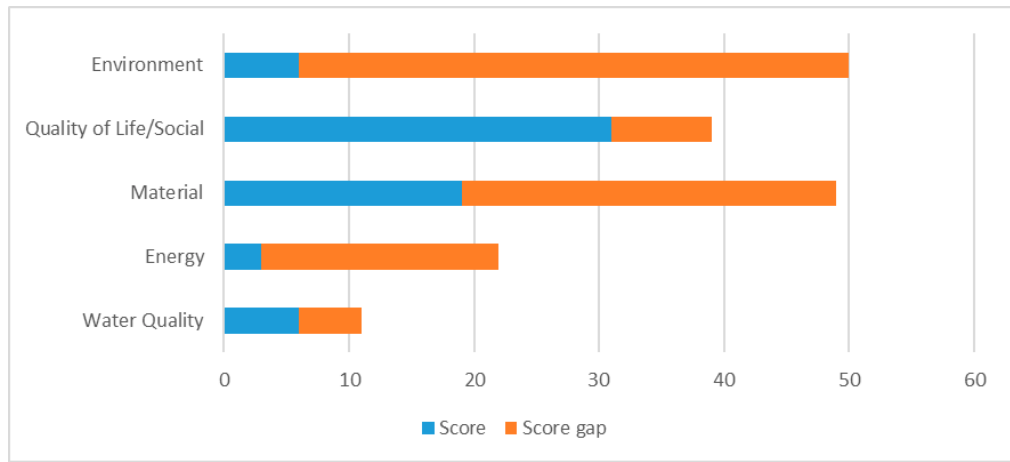
Figure 4. Points achieved in relation to applicable points across each category of the triple bottom line used in this Research for the INVEST rating system for Project 1.